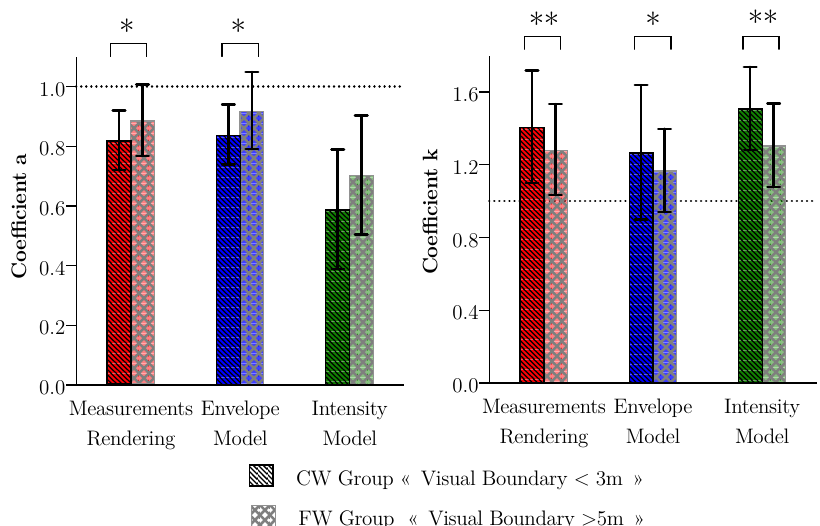
Figure 5. Mean and standard deviation of individual fitting coefficients a ( left ) and k ( right ) classed by groups (CW group (black, n = 55) and FW group (gray, n = 53)) and by rendering methods: measurements-based (red), envelope-based model (blue), and the intensity-based model (green). Coefficients for FW group are closer to 1 compared to those obtained for the CW group, demonstrating a lower compression effect of auditory distance perception. (*) t -test indicated a p -value p < 0.05; (**) t -test indicated a p -value p <